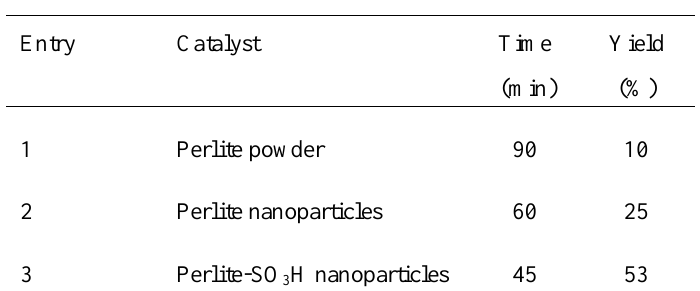
Table 2. Optimization Amount of perlite-SO